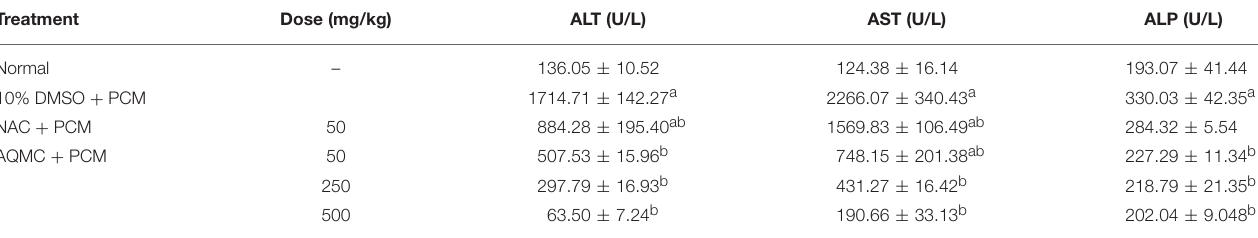
Values are expressed as means ± S.E.M. of six replicates. a Significant different as compared to normal control, P < 0.05. b Significant different as compared to negative control (10% DMSO + PCM), P < 0.05.